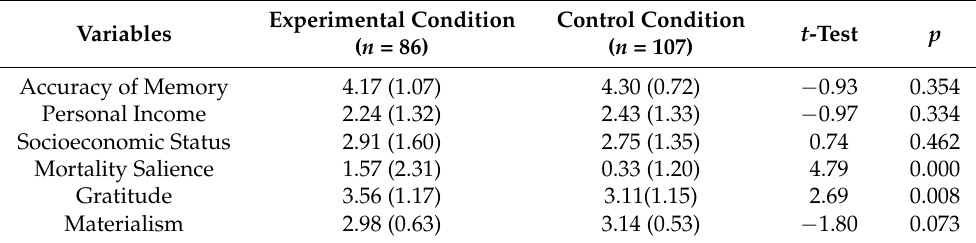
Table 1. Descriptive information of